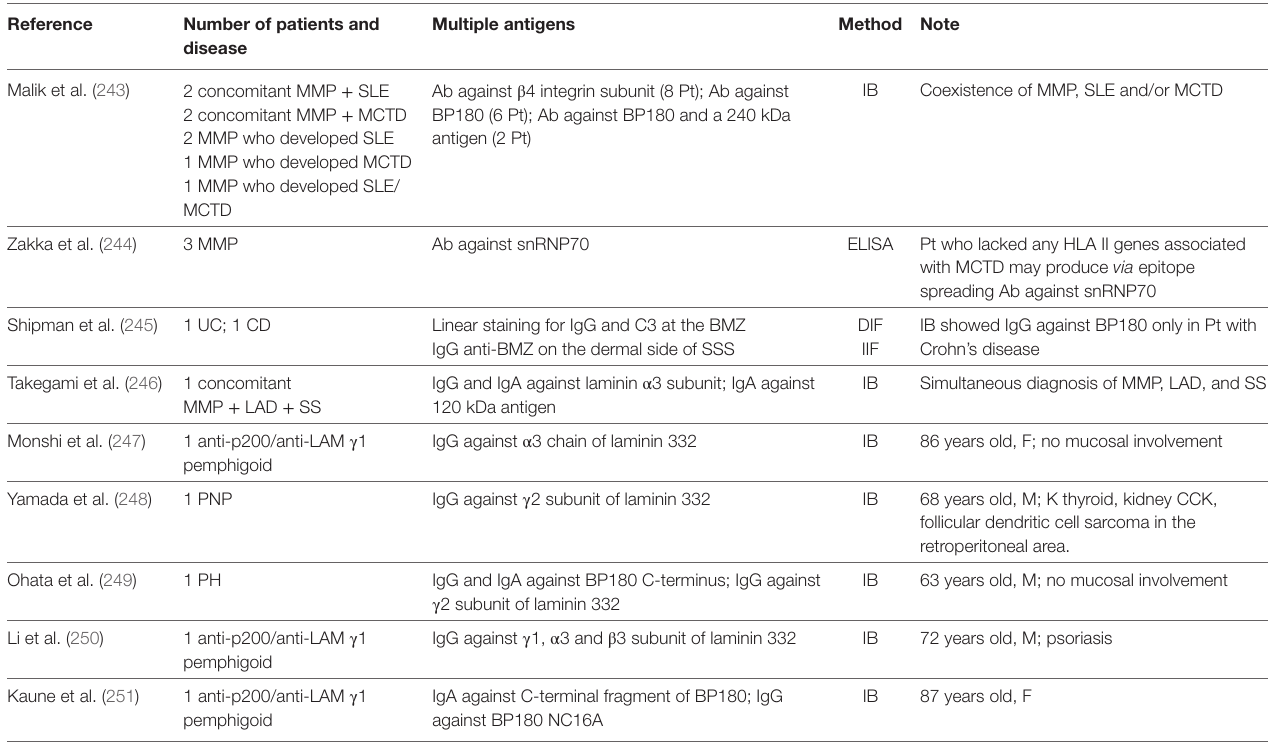
TABLe 7 | MMP patients associated with other autoimmune